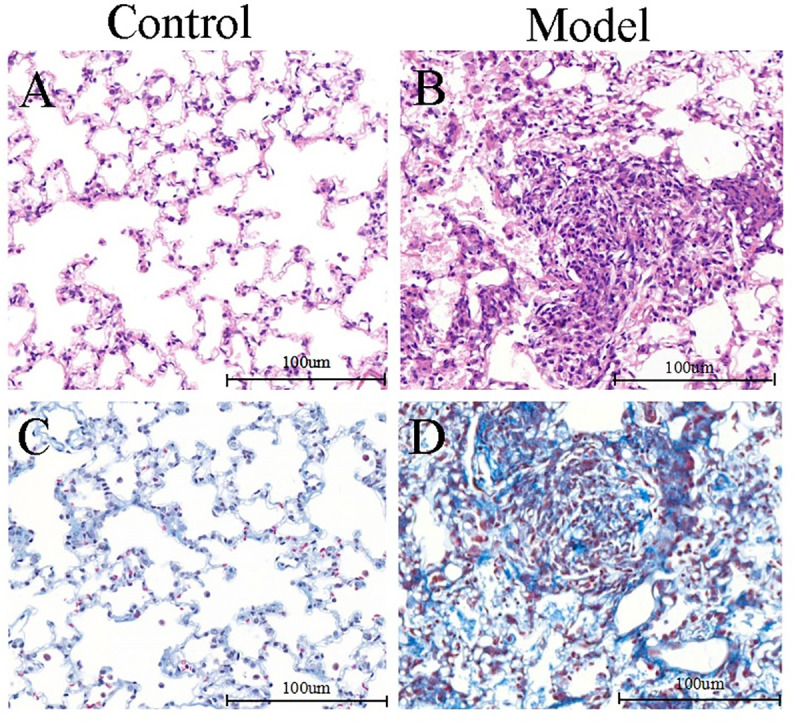
Histological examinations of lung of rat from the control and model groups.A: Lung from a control rat (HE, ×200); B: Lung from a rat of pulmonary fibrosis filled with inflammatory cell infiltration, thickened alveolar walls, damaged alveolar structures, increased fibronodules and macrophage aggregation (HE, ×200). C: Lung from a control rat (Masson, ×200); D: Lung from a rat of pulmonary fibrosis filled with more and thicker collagen fibers, damaged alveolar septum accompanied by a small amount of inflammatory cell infiltration, forming a diffuse fibrosis nodular changes (Masson, ×200).